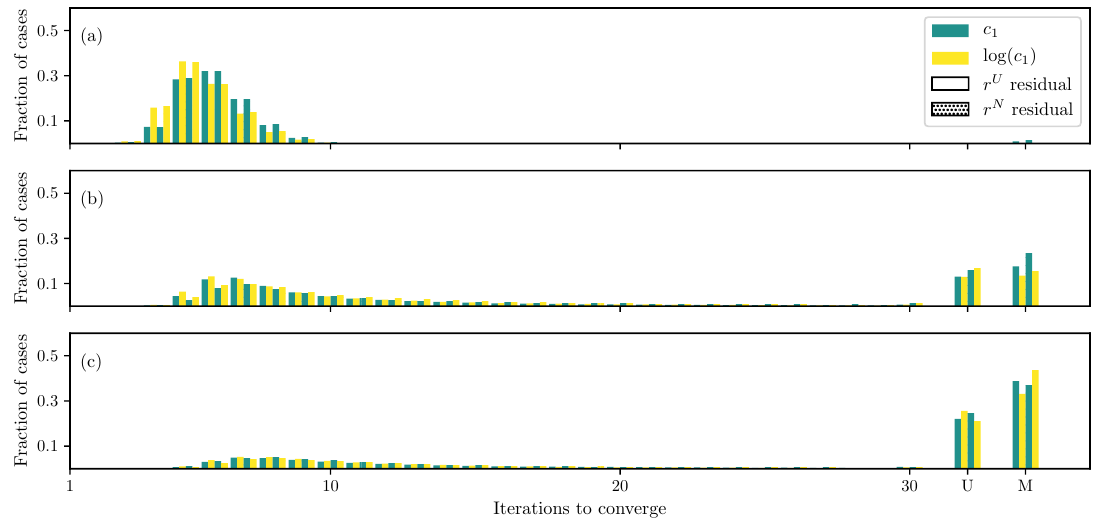
Figure 10. Iterations required using different formulations for the May-Newman model FC case when ( a ) only c 1 and c 2 are unknown, ( b ) all parameters except the fiber angle θ are unknown, and ( c ) all parameters are